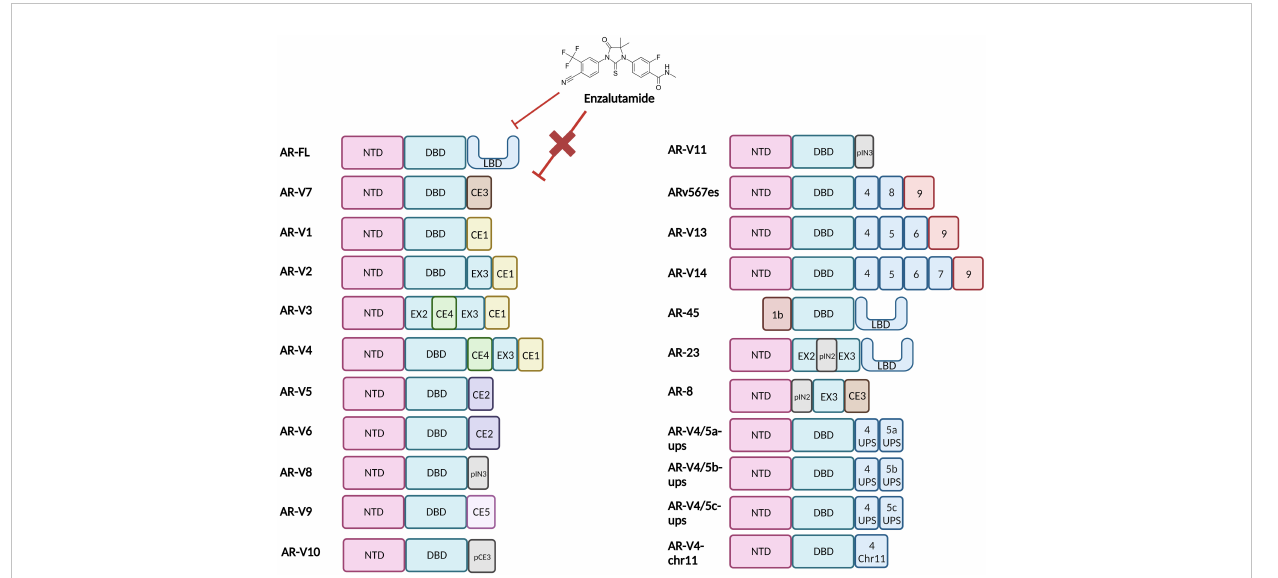
FIGURE 2 Structural representation of the Androgen Receptor and Androgen Receptor Variants. Full length Androgen Receptor (AR-FL) protein consists of three functional domains: an amino-terminal domain (NTD), DNA-binding domain (DBD) and Ligand-binding domain (LBD). Between the DBD and the LBD is a small hinge region (not shown). The AR gene resides on the X chromosome with 8 exons coding for the protein. Exon 1 codes for the N-terminal domain (NTD), exons 2 & 3 code for the DNA-binding domain (DBD) and exons 4-8 code for the hinge region (HR) and the ligand- binding domain (LBD). The NTD is the primary driver of AR-dependent transcription, the charged DBD allows interaction of AR with the DNA and the hydrophobic LBD facilitates androgen binding. Truncated AR variants (AR-Vs) lack the LBD (e.g. AR-V1 to AR-V14, inclusive of ARv567es) and instead, contain cryptic exons or partial LBD-coding exons or are non-functional and/or carry out alternate functions. In all cases these alterations diminish the ability of the AR to bind to ligands and subsequently be inhibited by LBD-targeting drugs such as Enzalutamide. CE, Cryptic Exon; EX, Exon; IN, Intron; p,